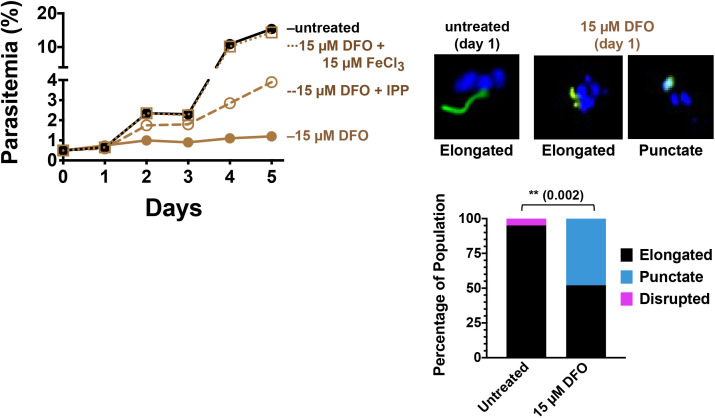
Effect of deferoxamine on parasite growth and apicoplast biogenesis.(Left) Continuous growth assay of sorbitol-synchronized Dd2 parasites cultured without or with 15 µM deferoxamine (DFO), 15 µM FeCl3, or 200 µM IPP. (Right) Fluorescence microscopy of live, synchronized D10 parasites untreated or treated with 15 µM DFO and imaged 36 hr later (green = ACPL GFP, blue = nuclear Hoechst stain). Twenty to 30 total parasites were examined for each treatment condition on each given day for duplicate experiments, and data were plotted as the average percentage of parasites in each population that displayed an elongated, punctate, or dispersed apicoplast GFP signal. For clarity, error bars are not displayed but standard errors of the mean were <15% in all conditions. Cell-percentage differences were analyzed by two-tailed unpaired t-test (p value in parenthesis).